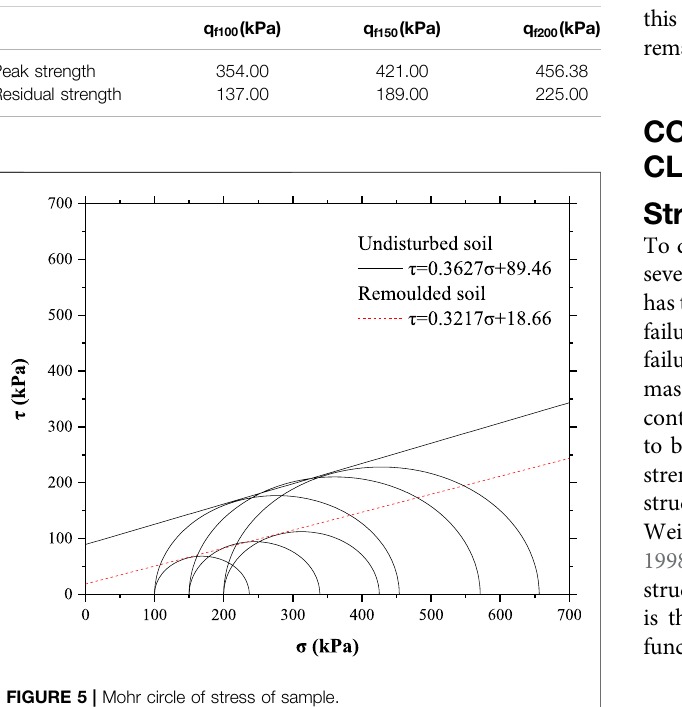
TABLE 1 | Strength value of undisturbed soil